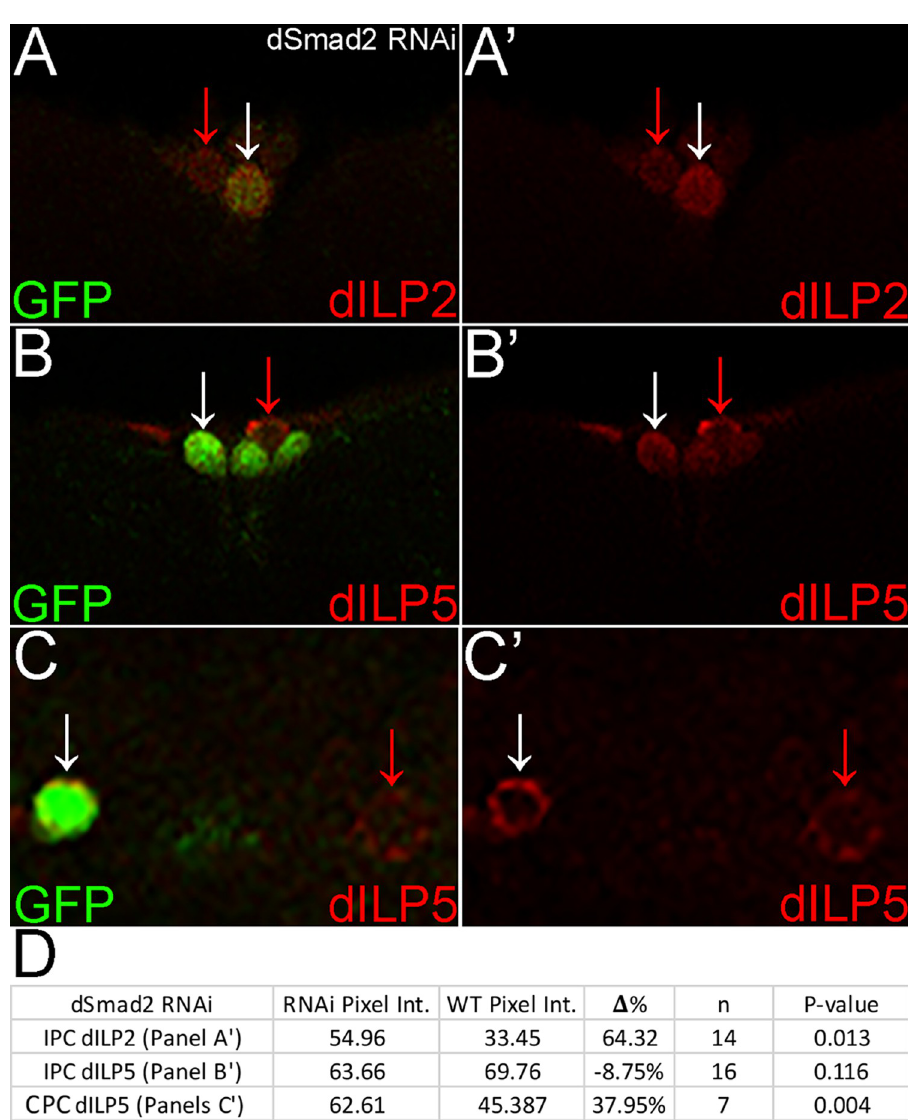
RNAi pixel intensity comparisons in IPCs and